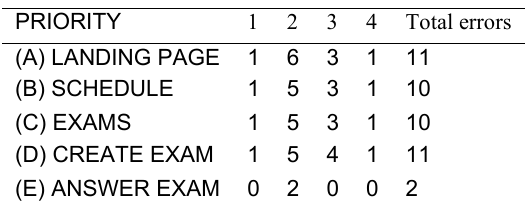
Table 4. Number of usability errors by section